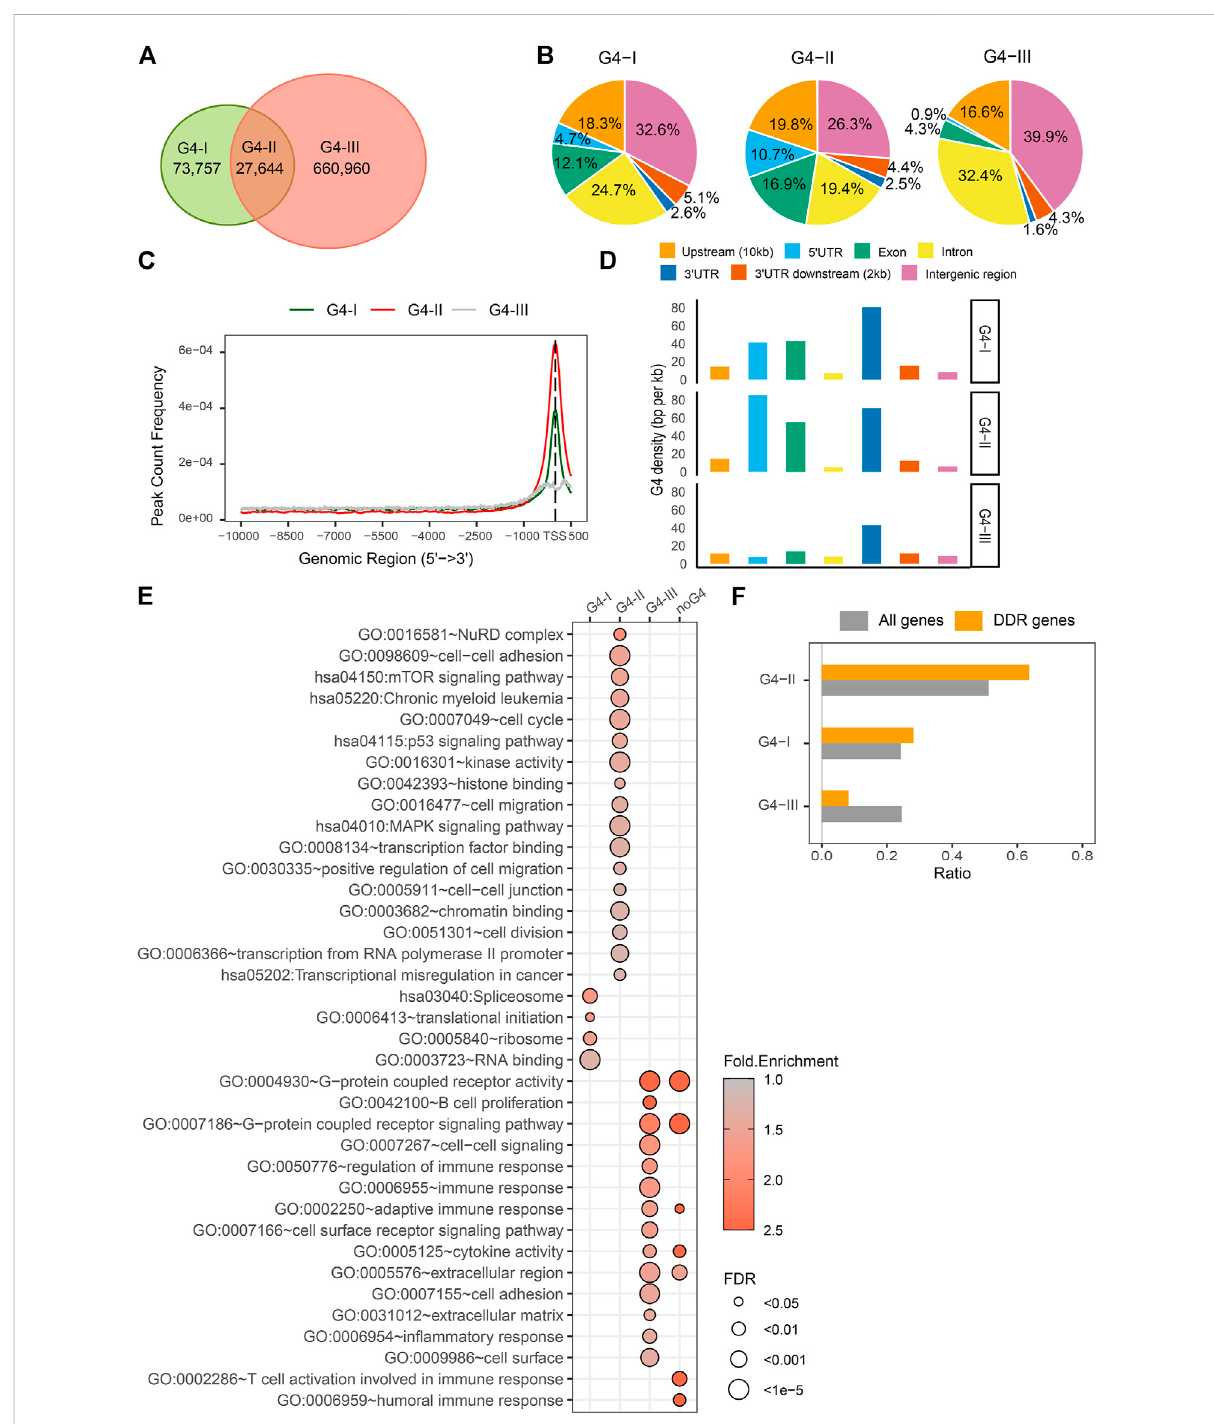
FIGURE 2 DistinctfeaturesandbiologicalfunctionsofthreeG4groups. (A) NumbersofG4regionscon fi rmedbyG4ChIP-seqonly(G4-I)orcon fi rmedby the ChIP-seq and predicted by G4Hunter (G4-II), or only predicted by the G4Hunter (G4-III). (B) Distributions of three G4 groups in genome locations, including upstream up to 10 kb from gene transcription start sites (TSSs), 5 ′ UTR, exons, introns, 3 ′ UTR, 2 kb downstream of 3 ′ UTR, and intergenic region. (C) Distances of different G4 groups from TSS. (D) G4 density (BPKB) in different genome locations for three groups. (E) Signi fi cantly enriched GO terms and KEGG pathways in the gene sets with different G4 groups or without any G4 sequences in the upstream. (F) Ratios of DDR genes associated with three G4 groups compared to all